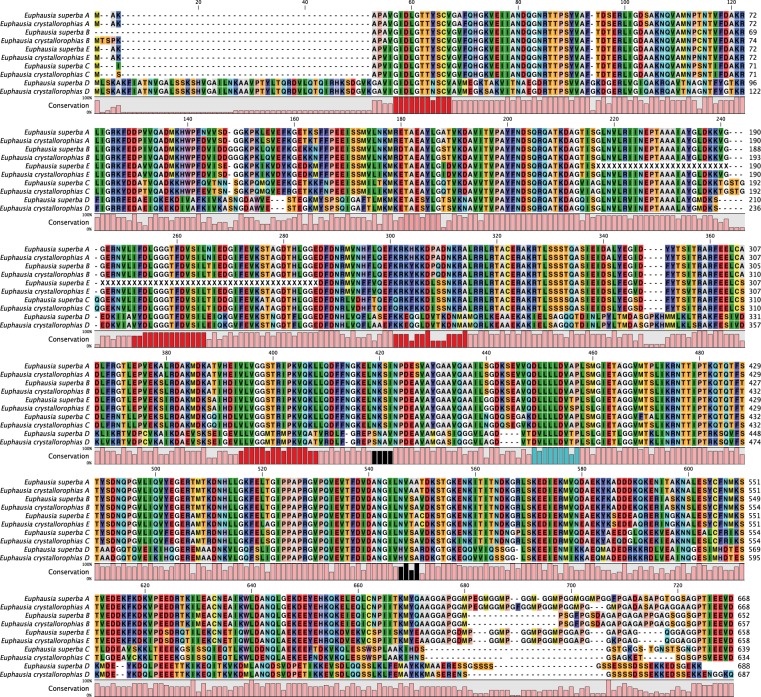
Alignment of five Hsp70 isoforms from E. superba and E. crystallorophias.In red: Hsp70 diagnostic motifs; in black: possible glycosylation sites; in blue: hydrophobic linker between Nucleotide Binding Domain and Substrate Binding Domain.